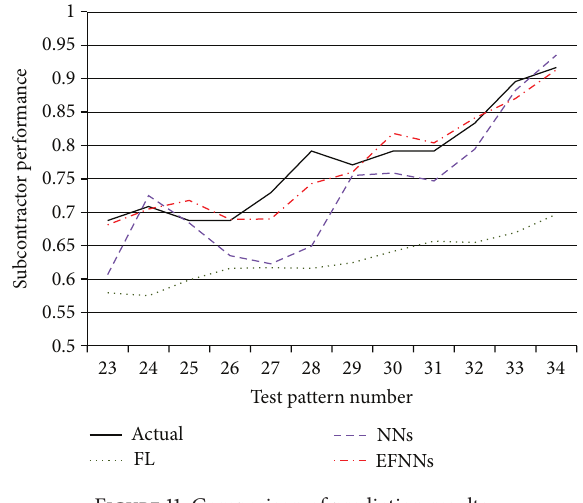
Figure 11: Comparison of prediction results. Table 2: EFNN